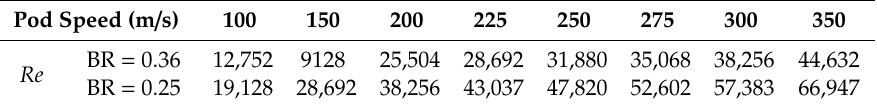
Table 2. Variation of Reynolds number ( Re ) with respect to pod speed and